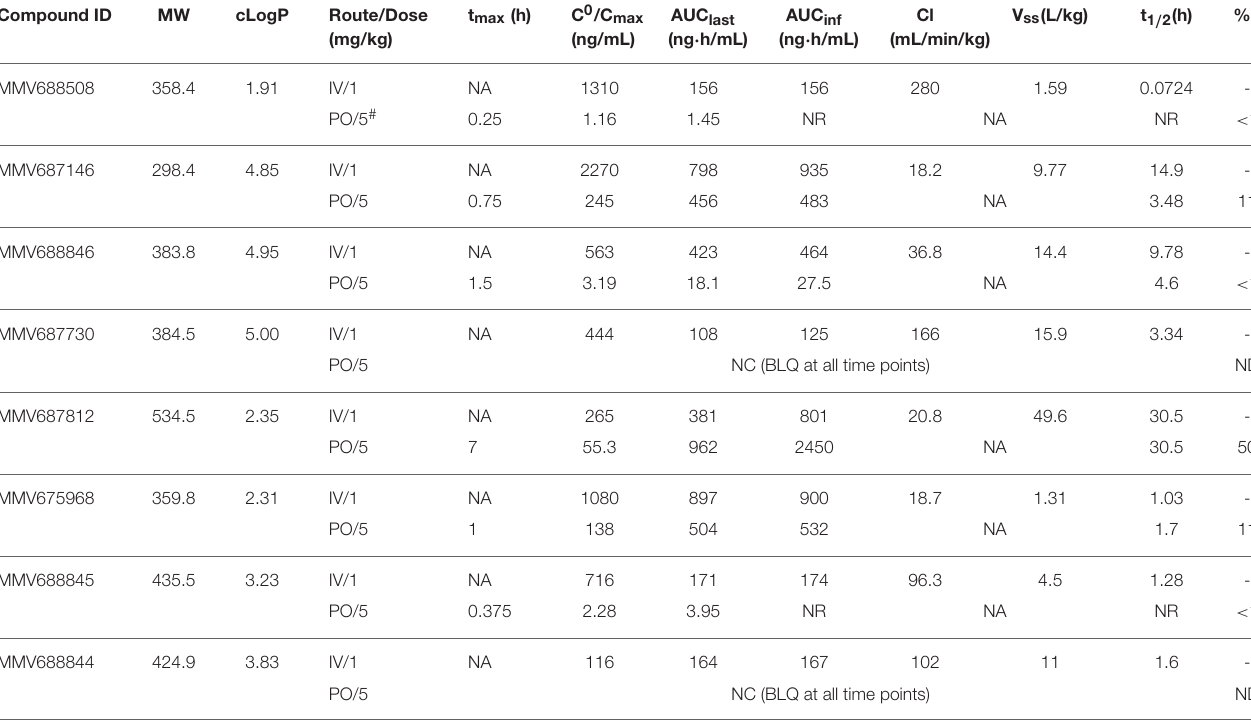
TABLE 2 | Physicochemical and in vivo pharmacokinetic properties of top NTM hits identified in the Pathogen Box screen a . Compound